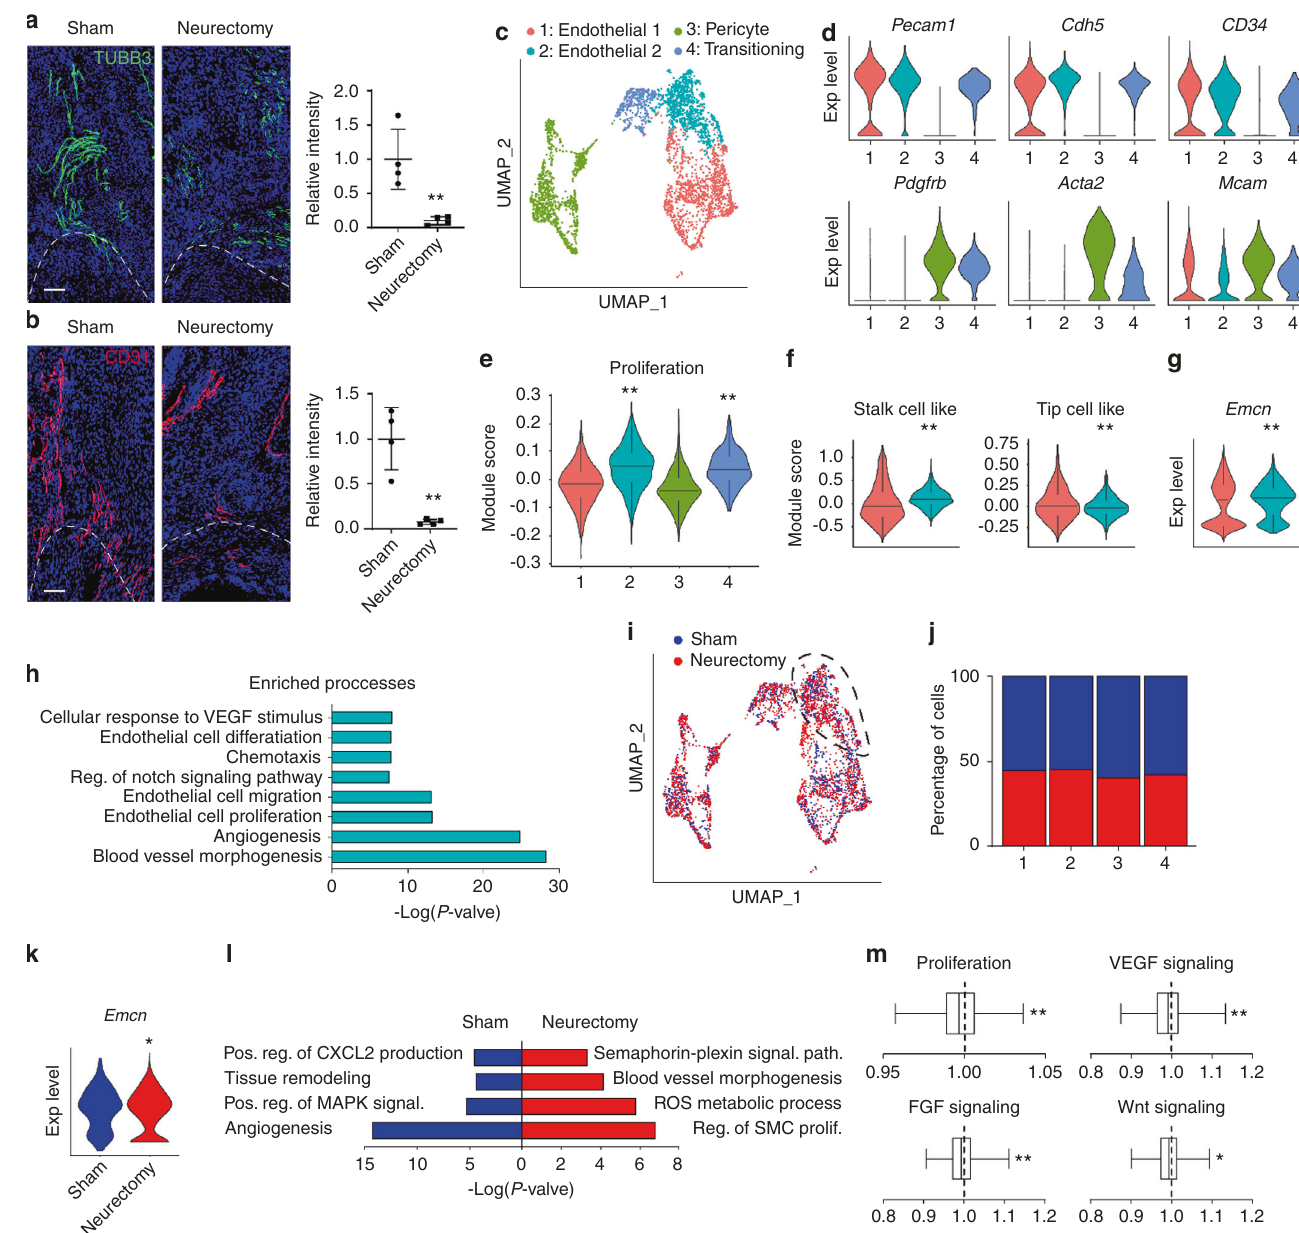
Fig. 3 Neurectomy impairs blood vessel in fi ltration after soft tissue trauma. Animals underwent proximal sciatic neurectomy or sham surgery at the time of HO induction. a TUBB3 (Beta III Tubulin) immunostaining and quanti fi cation within the tendon injury site among sham or neurectomized mice, 21 d post-injury. b CD31 immunostaining and quanti fi cation within the tendon injury site among sham or neurectomized mice, 21 d post-injury. Dashed white lines indicate edges of Achilles tendon. c – l ScRNA-seq analysis of the HO site at 7 d post injury, among sham or neurectomized animals. c UMAP visualization of subclustering of endothelial and pericyte populations. d Violin plots of characteristic gene markers identifying four vascular subclusters. Pecam1 (Platelet endothelial cell adhesion molecule 1), Cdh5 (Cadherin 5), Pdgfrb (Platelet-derived growth factor receptor beta), Acta2 (Actin alpha 2), Mcam (Melanoma cell adhesion molecule). e Modular index scoring for cell proliferation across subclusters. f Module index scoring for ‘ stalk cell-like ’ and ‘ tip cell-like ’ phenotypes across Endothelial 1 and Endothelial 2 subclusters. g Emcn expression across Endothelial 1 and Endothelial 2 subclusters, by violin plot. h GO terms enriched in Endothelial 2 subcluster as compared to Endothelial 1. i UMAP visualization of vascular cell subclusters with or without sciatic neurectomy. j Cellular percentage of Endothelial 2 subcluster with or without sciatic neurectomy. k Emcn expression in Endothelial 2 subcluster in the context of sham or neurectomy conditions, as shown by violin plot. l GO term analysis of endothelial 2 subcluster in the context of sham and neurectomy surgery. m Module index scoring of proliferation, VEGF (Vascular endothelial growth factor) signaling, FGF (Fibroblast growth factor) signaling, and Wnt signaling under neurectomy conditions in comparison to sham control. Values greater than 1 indicates increased signaling activation in neurectomy group while values less than 1 indicates reduced expression among the neurectomy group. Scale bars: 100 μ m. For histology, n = 4 animals per condition. For scRNA-Seq, n = 3 animals per condition. Individual dots in scatterplots represent values from single animal measurements, while mean and one SD are indicated by crosshairs and whiskers. * P < 0.05; ** P < 0.01 in relation to endothelial subcluster 1 ( e – g ) or sham control ( a , b , k , l ). A two-tailed student ’ s t test was used for two-group comparisons ( a , b , f , g , k , l ). For more than two groups, non-parametric data was analyzed using the Kruskal – wallis with Dunn ’ s multiple comparison test ( e ). Non-parametric data was analyzed using the Kolmogorov – Smirnov test ( f , g , m